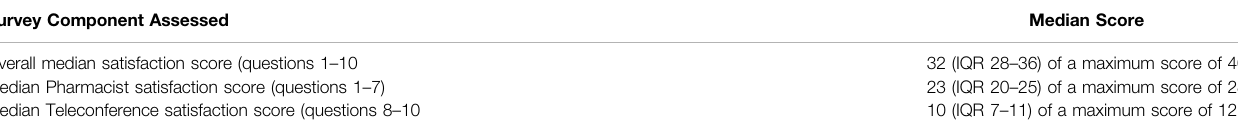
TABLE 6 | Results of survey assessing patient satisfaction with teleconference provided by clinical pharmacists. Survey Component